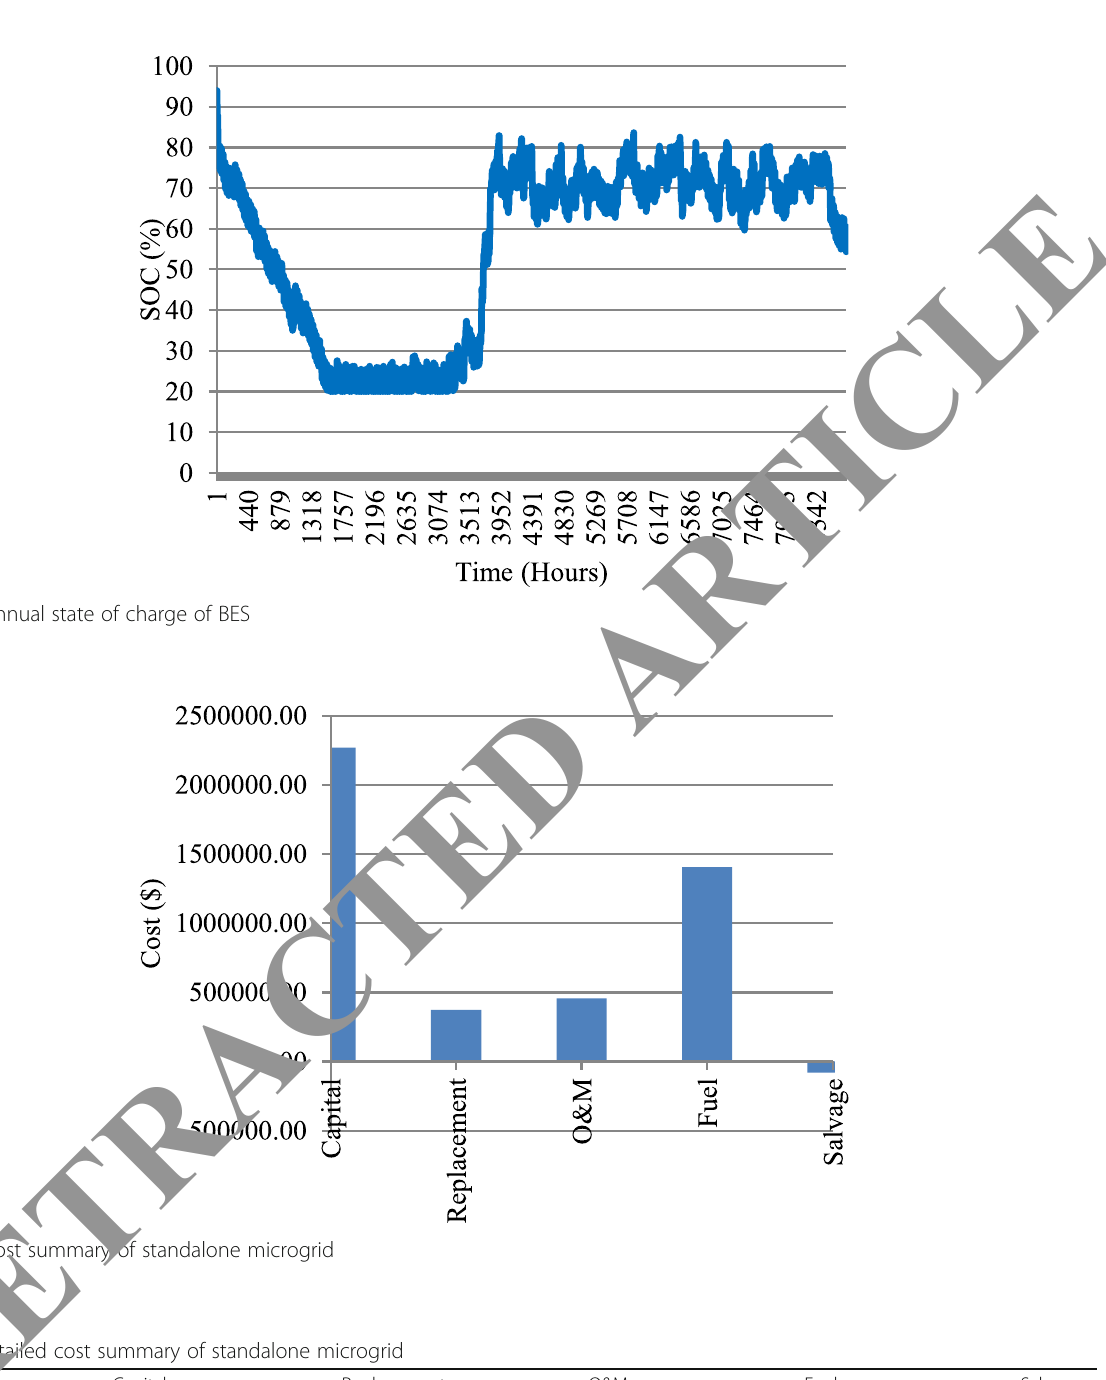
Table 4 Detailed cost summary of standalone